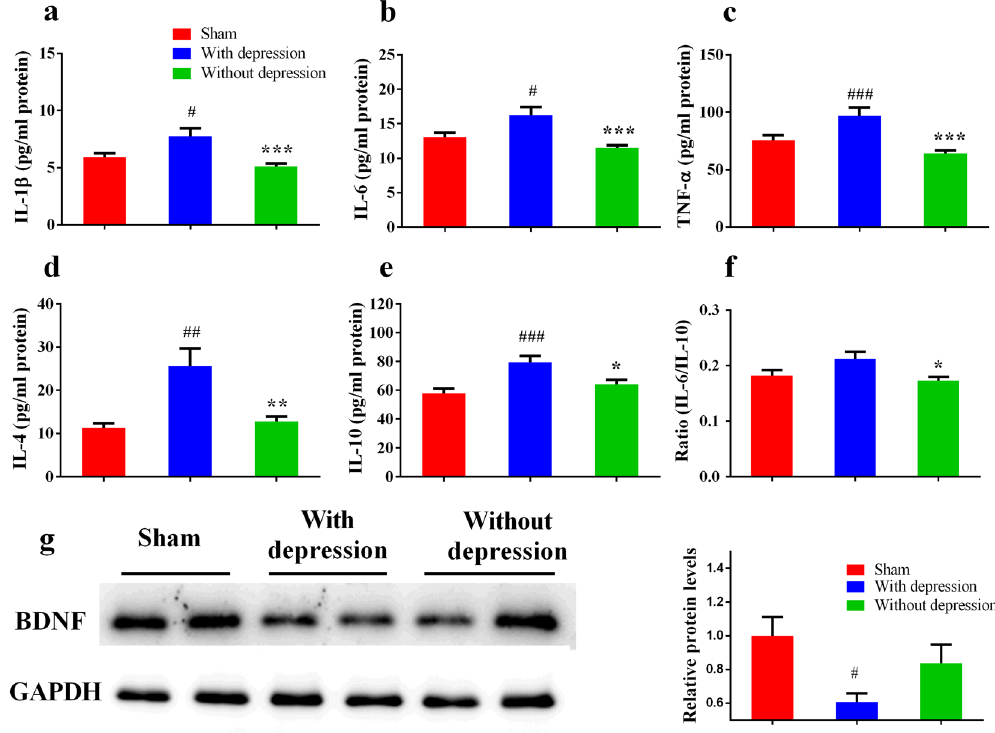
Figure 3. Expression of inflammatory cytokines in the PFC. ( a ) The levels of IL-1 β in the PFC from rats with depression-like phenotype were higher than sham-operated rats and rats without depression-like phenotype. ( b ) The levels of IL-6 in the PFC from rats with depression-like phenotype were higher than sham-operated rats and rats without depression-like phenotype. ( c ) The levels of TNF- α in the PFC from rats with depression-like phenotype were higher than sham-operated rats and rats without depression-like phenotype. ( d ) The levels of IL-4 in the PFC from rats with depression-like phenotype were higher than sham-operated rats and rats without depression-like phenotype. ( e ) The levels of IL-10 in the PFC from rats with depression-like phenotype were higher than sham-operated rats and rats without depression-like phenotype. ( f ) There was no difference of the ratio of IL-6 to IL-10 between rats with depression-like phenotype and sham-operated rats. The ratio of IL-6 to IL-10 in the rats without depression-like phenotype was lower than rats with depression-like phenotype. ( g ) Western blot analysis of BDNF in the PFC after SNI surgery. # P < 0.05, ## P < 0.01 and ### P < 0.001 vs sham group; * P < 0.05, ** P < 0.01 and *** P < 0.001 vs rats without depression-like phenotype. Each group, n = 6 or 7 for Elisa and n = 4 for western